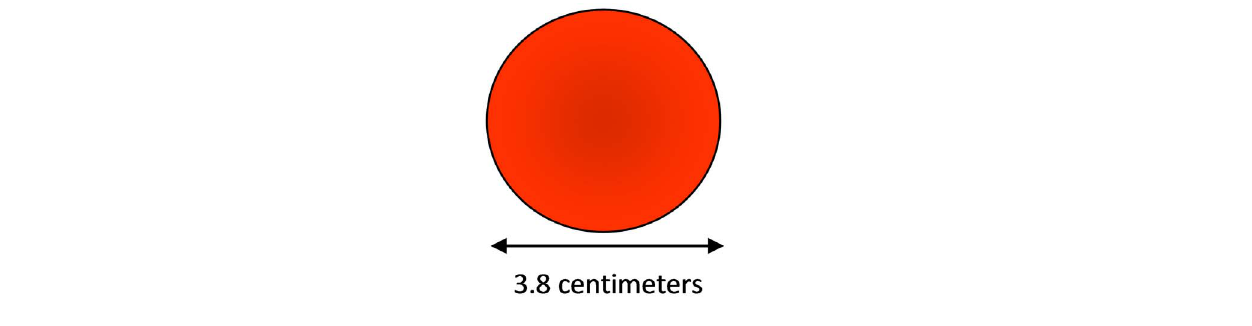
Figure 2. Description of Non-Draining Sore Vignette.